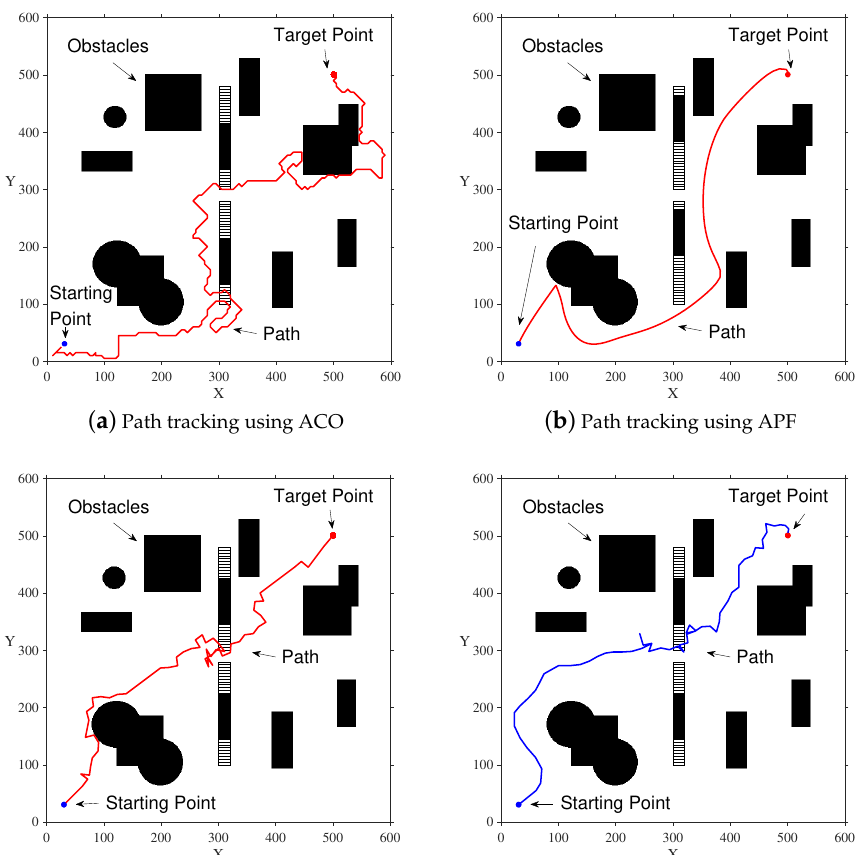
Figure 5. Simulation results of simulation